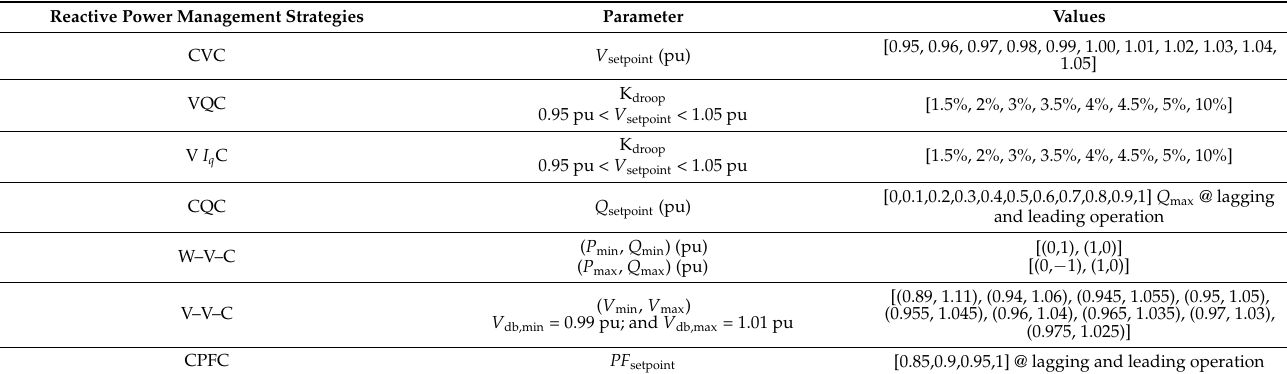
Table A1. Range of values considered in the parameter sensitivity analysis of the local-reactive power management